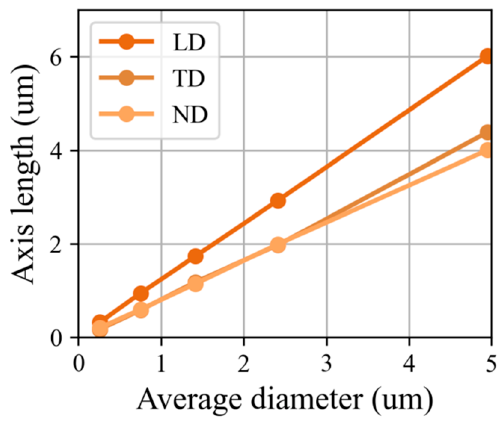
Figure 8. Average length of the equivalent ellipsoid axis for each of the grain size bins into which the EBSD data is divided (see also Figure 2).